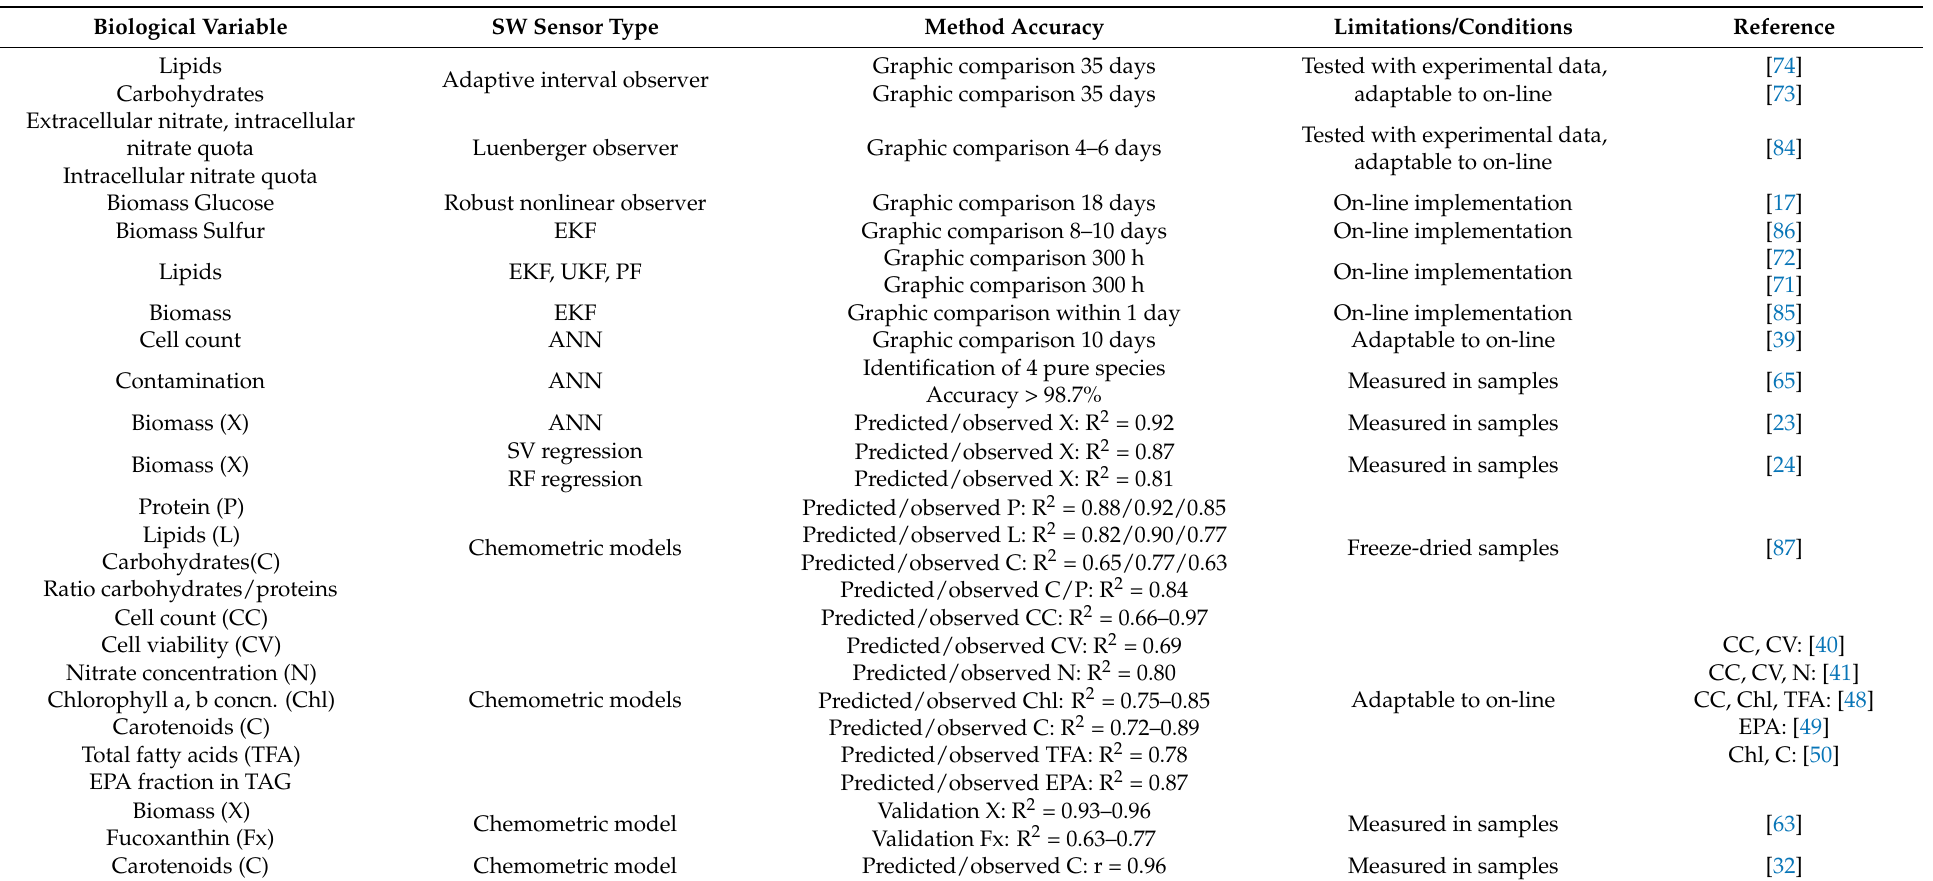
Table 4. Accuracy of software sensor methods where numerically available. In most cases, only graphs comparing the time course of variables’ estimation vs. their measurement are shown in the original article (denoted here as “graphic